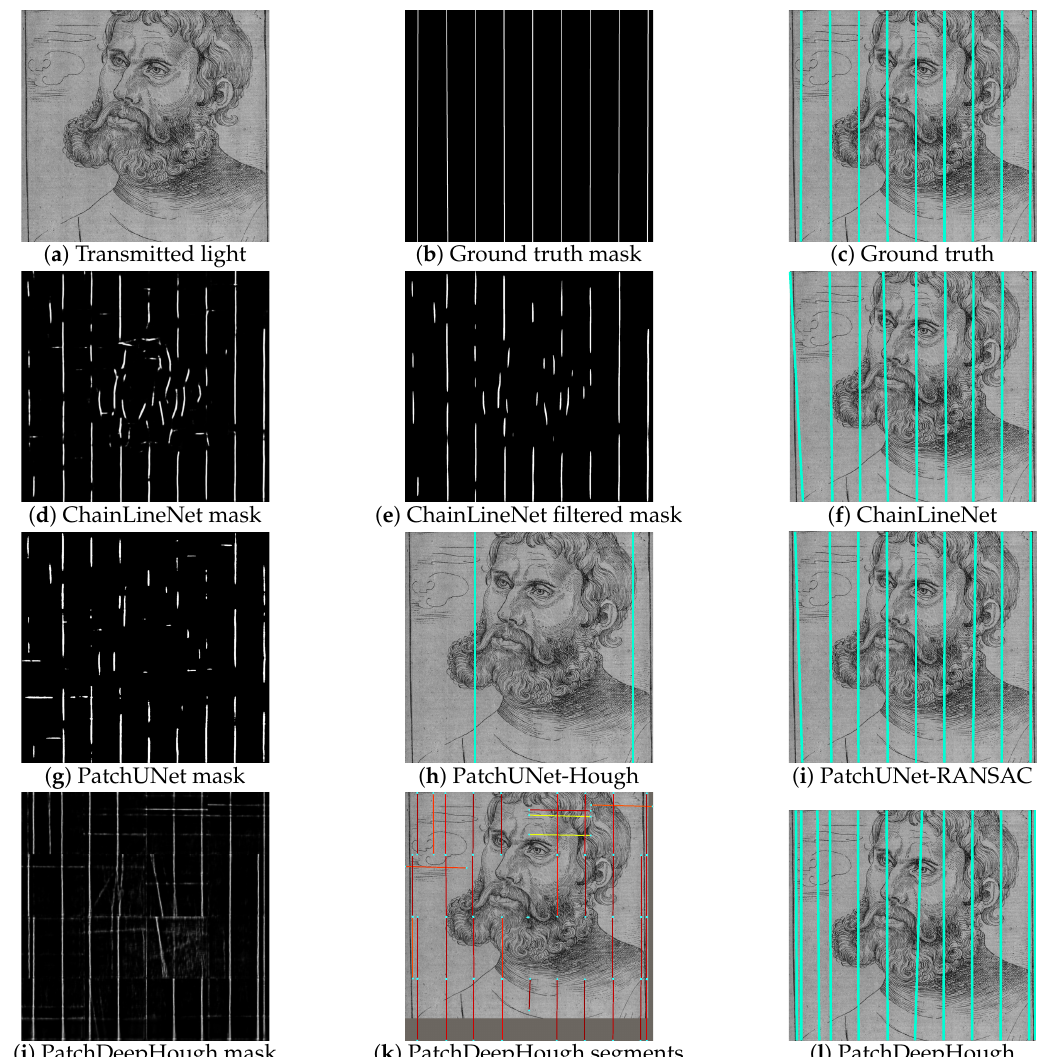
Figure 10. Qualitative results of the chain line detection for one historical print containing vertical chain lines and a watermark. Transmitted light image (detail): After Lucas Cranach the Elder, Martin Luther as Junker Jörg , Collotype, Kunstsammlungen der Veste Coburg, H.0064; captured by Thomas Klinke; all rights reserved by the respective